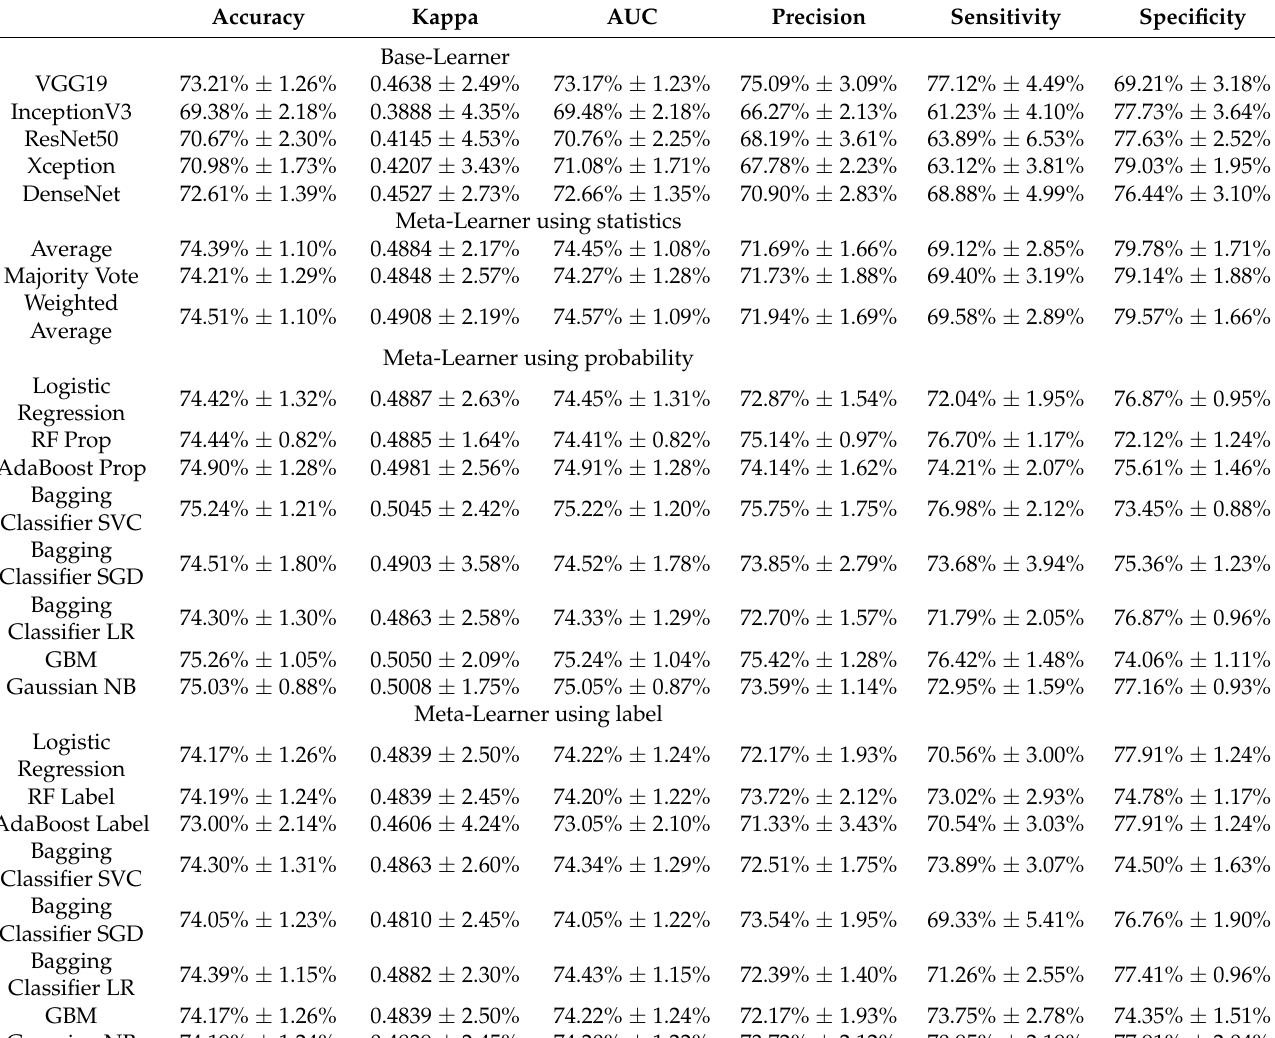
Table A7. The Kappa score achieved by each classifier for the shoulder images ( ± Confidence Interval 95%). Test performance is reported.